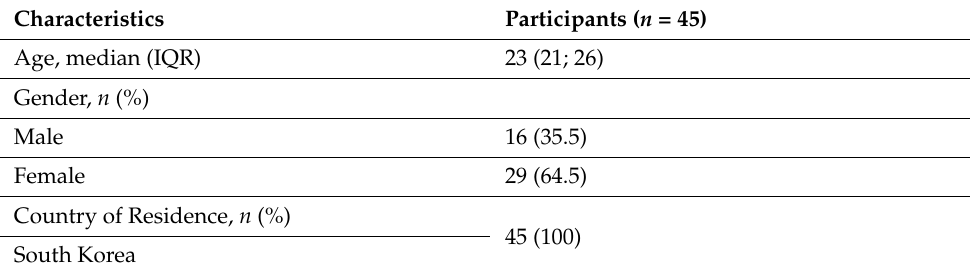
Table 3. Baseline characteristics of participants (N = 45).